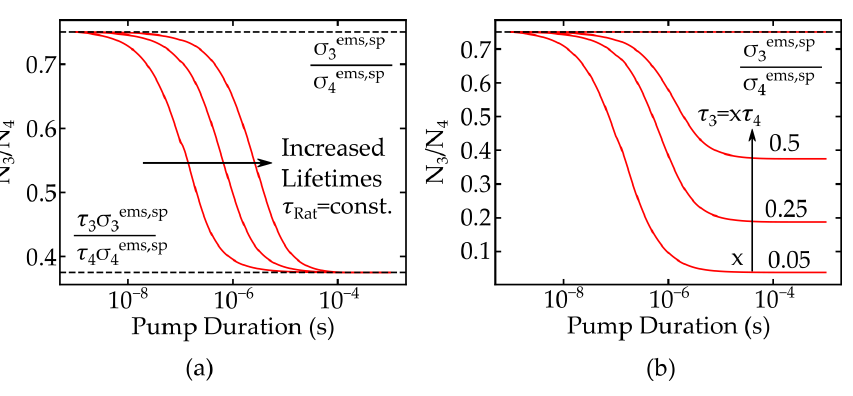
Figure 2. Relative relations of the population densities N 3 and N 4 of lower laser levels, as defined in Figure 1, depending on the pump duration. Depicted in ( a ) are relations for a constant ratio τ Rat of the emission lifetimes and in ( b ) for different